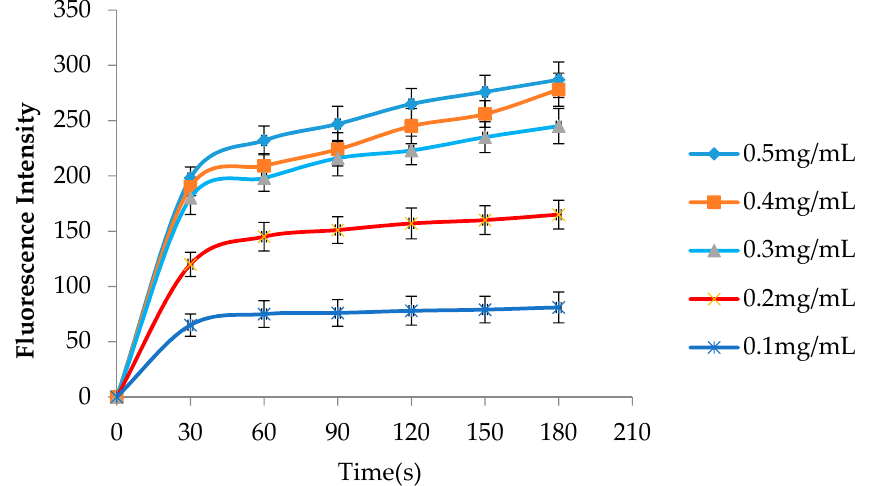
Figure 2. Effects of hLYS on permeability of the H. pylori outer membrane. The hLYS with different concentrations detect its ability of increasing membrane permeability through the change of the fluorescence intensity with time.